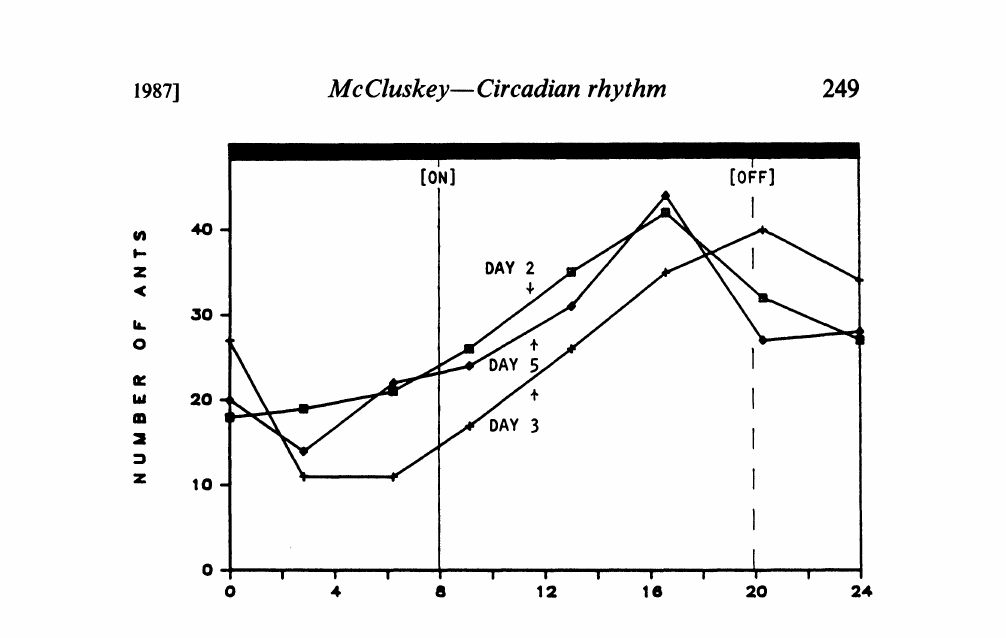
Fig. 3. Same group of E. tuberculatum, in same artificial nest, as in Fig. 2. DD arena rhythm, following single exposure to light for 12 h starting Feb. 13 at 2000. Day 2 Feb. 15-16, 3 Feb. 16-17, 5 Feb.